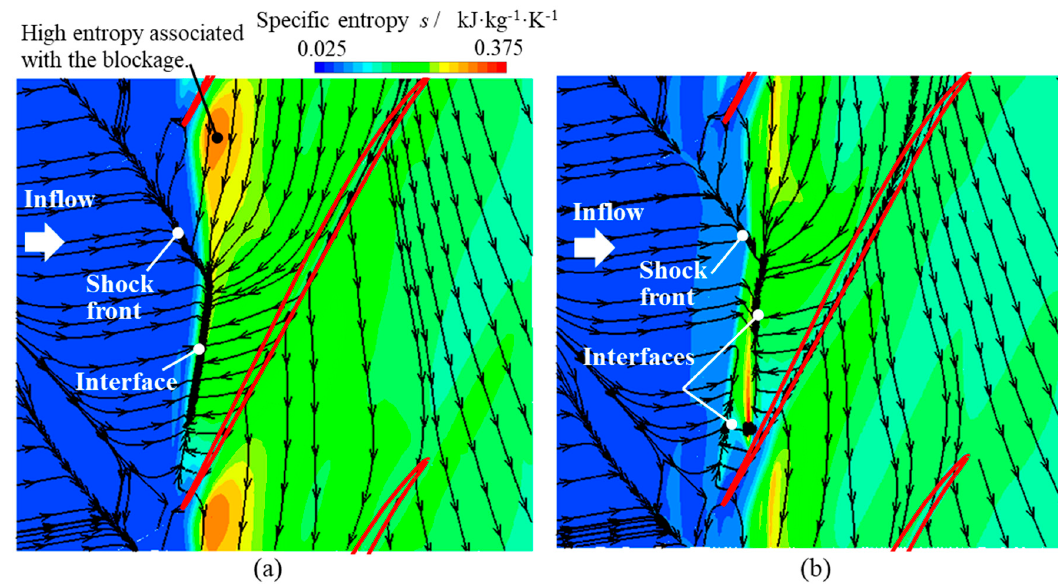
Figure 16. Surface streamlines and the entropy contours near the casing wall showing the creation of flow interfaces near the rotor LE. ( a ) BL (OP-D); ( b ) RC (OP-D).